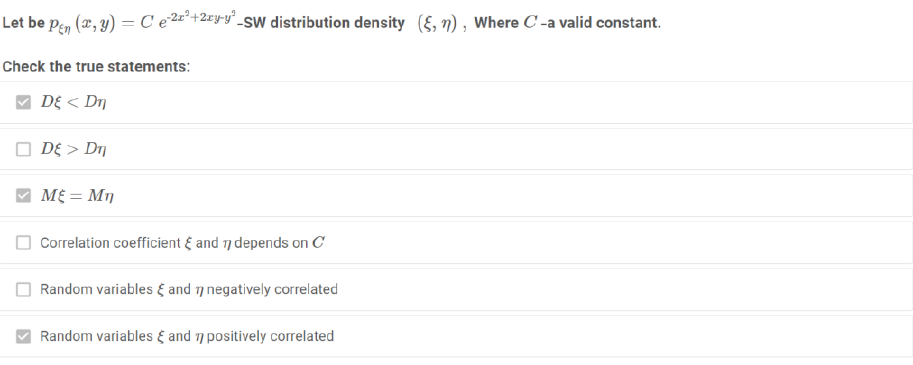
Fig. 6. Example of a test question for density properties in PTMS